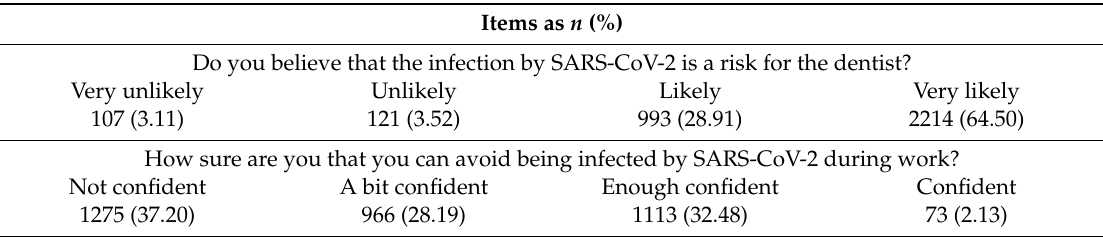
Table 8. Perception of risk related to COVID-19. Items as n (%)